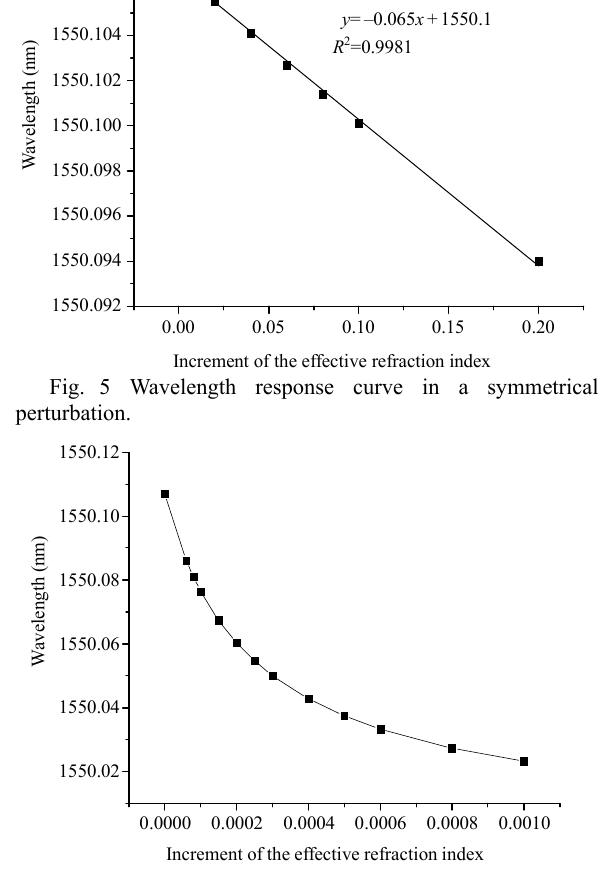
Fig. 6 Wavelength response curve in an asymmetrical perturbation.